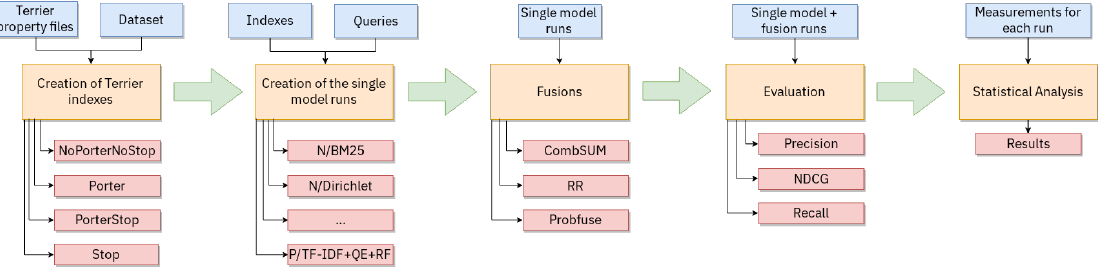
Figure 2. Graph showing the pipeline steps done in order to prepare the indexes and the